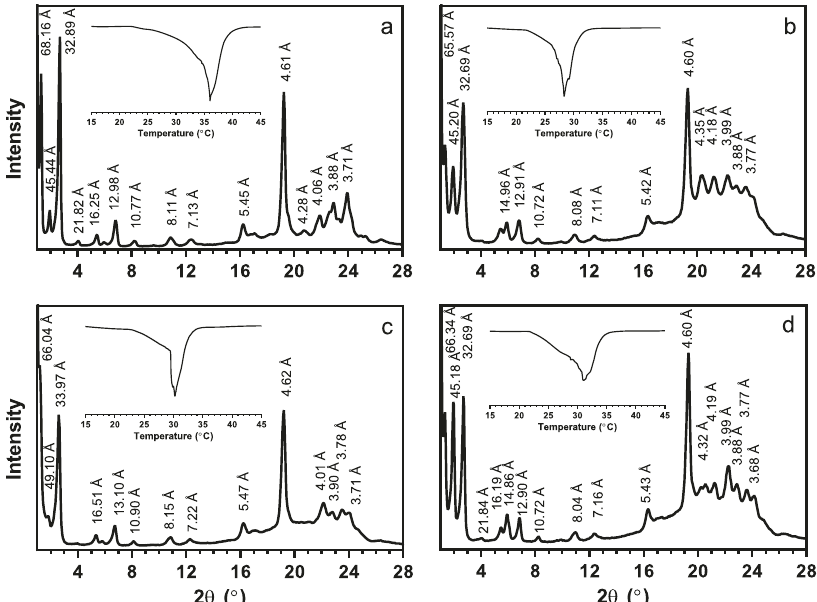
Fig. 1 Powder X-ray diffraction patterns and differential scanning calorimetric traces (inset) of unre fi ned native CB, re fi ned CB, and re fi ned CB with added minor lipidic components. Samples included a unre fi ned native CB, b re fi ned CB, c re fi ned CB with added 0.1% (w/w) dimyristoylphosphatidylcholine, and d re fi ned CB with added 0.1% (w/w) dipalmitoylphosphatidylethanolamine. Samples were crystallized statically at 23 °C for 24